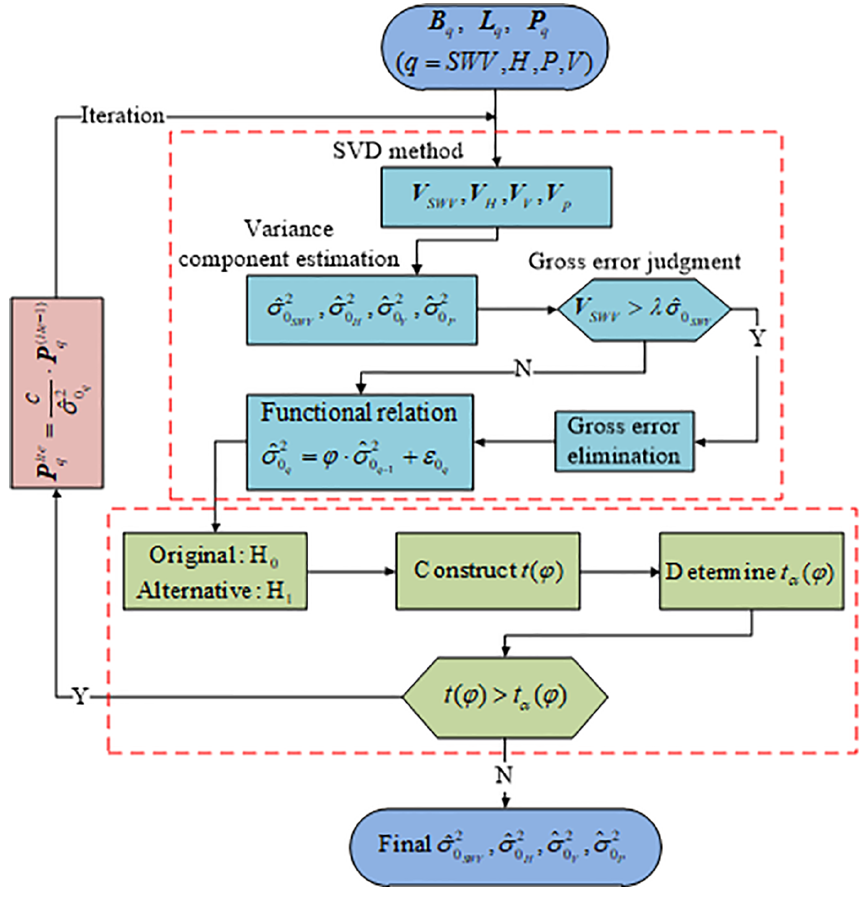
Figure 2. Flowchart of the proposed method considering the weightings for different types of equations.